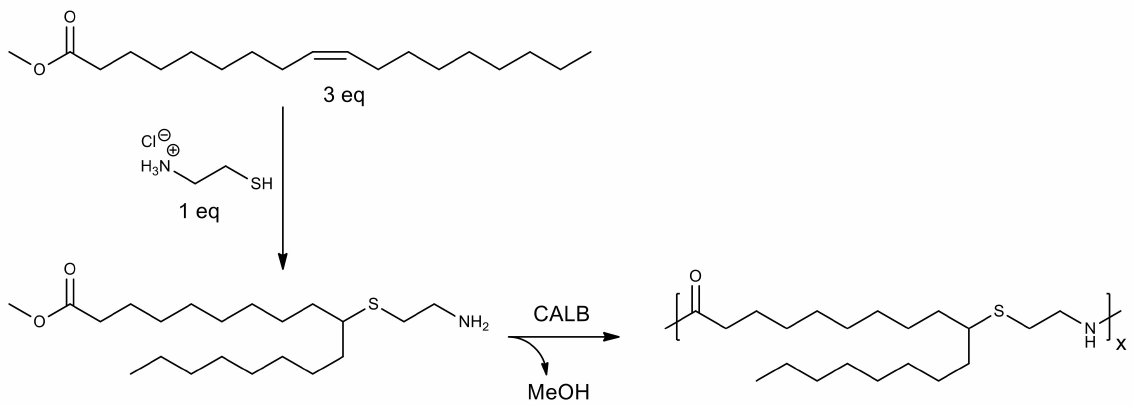
Figure 9. Chemoenzymatic synthesis of polyamide based on a monomer obtained by radical addition of cysteamine to methyl